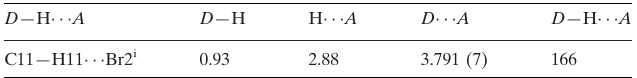
Hydrogen-bond geometry (A˚ , (cid:2)